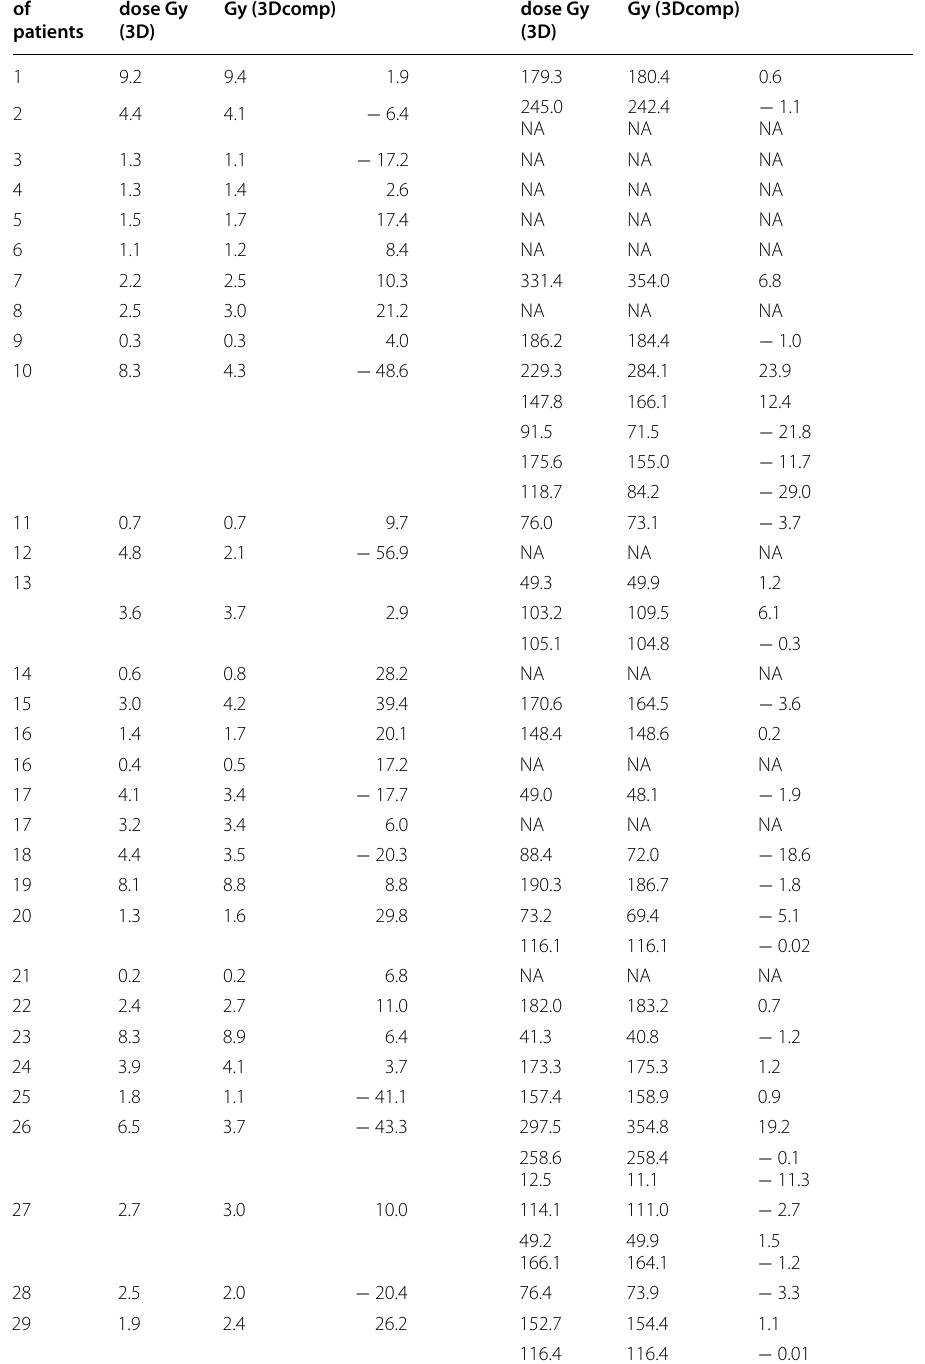
Table 4 Table of estimated absorbed doses to lungs and tumors from 3D and 3Dcomp